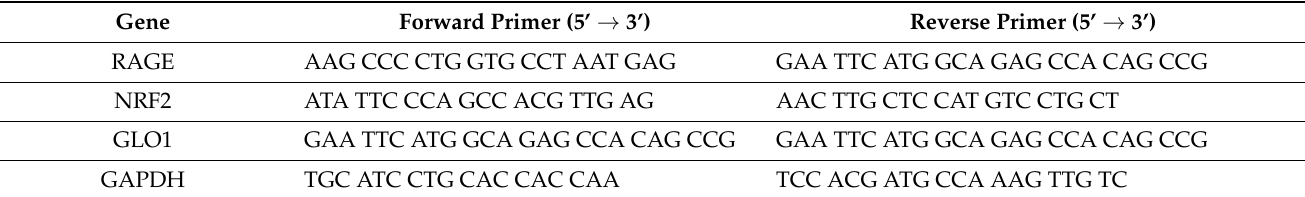
Table 1. Primer sequences for real-time